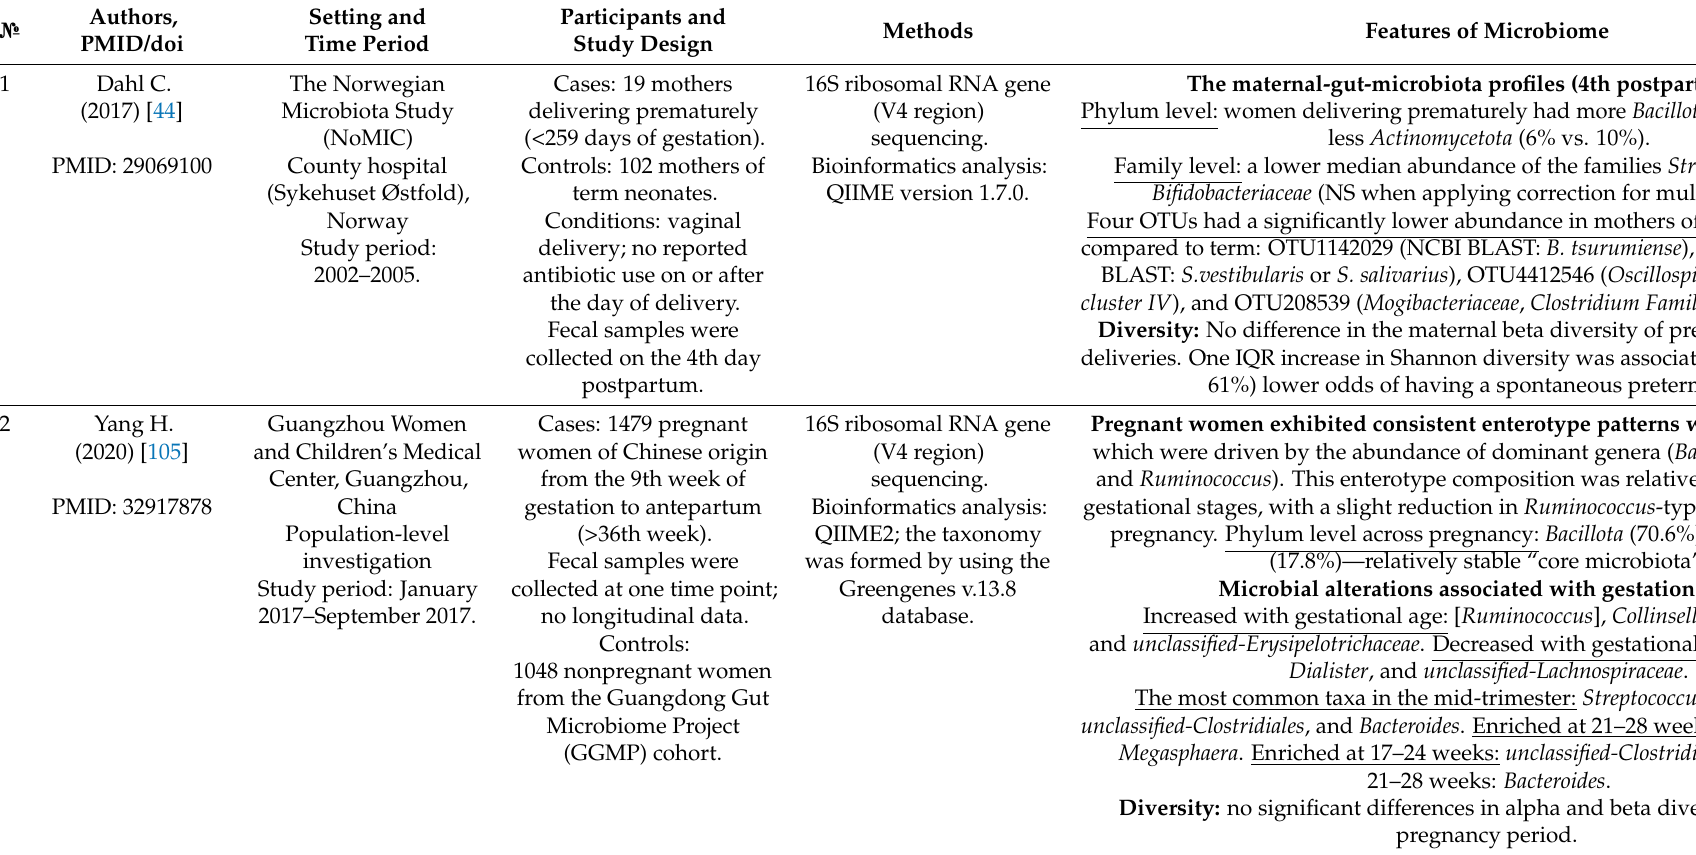
Table 2. Features of the intestinal microbiome in mothers delivering